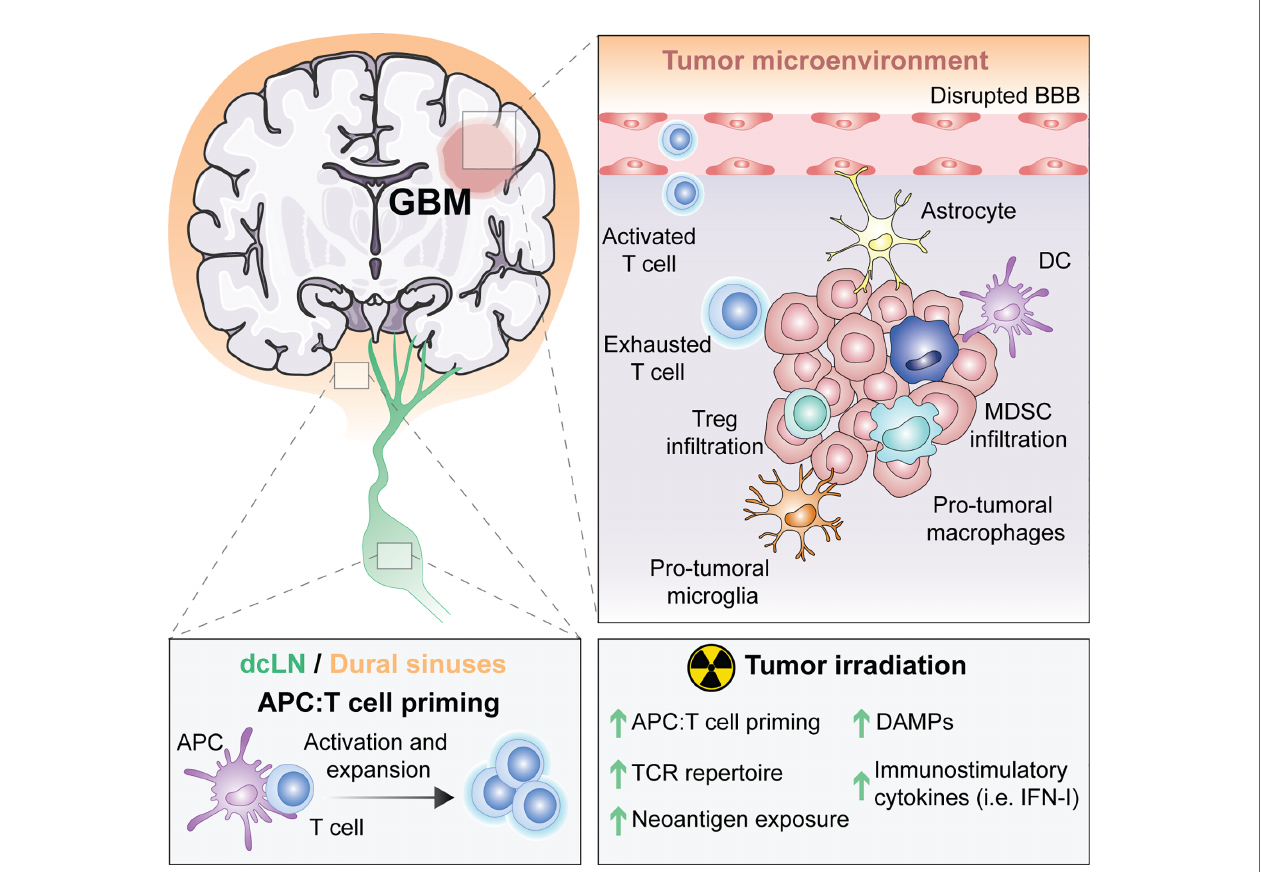
FIGURE 1 | The unique immune response in GBM and its modulation by RT. For many years, the central nervous system (CNS) was thought to be excluded from immune surveillance. However, it is now known that the CNS is not isolated from activated T cells and that CNS antigens can be presented locally or peripherally in the draining cervical lymph nodes or the dural sinuses. Diverse types of antigen presenting cells (APCs) exist within glioblastoma (GBM), including microglia, macrophages, astrocytes and classic APCs such as dendritic cells (DCs). APCs that have captured tumor antigens can present to naïve T cells, leading to their activation and expansion. Activated T cells migrate into the brain through a disrupted blood brain barrier (BBB), but once in the tumor microenvironment (TME) they differentiate into exhausted T cells. Within the TME, there are immunosuppressive regulatory T cells (Tregs), myeloid derived suppressor cells (MDSC), reactive astrocytes and pro-tumoral macrophages and microglia. Radiotherapy (RT), the standard of care for GBM, induces the exposure of tumor neoantigens and increases the T cell receptor (TCR) repertoire. Moreover, tumor irradiation promotes the release of danger associated molecular patterns (DAMPs) and type I interferon (IFN-I), which stimulate APCs cross-priming of T cells. All of these suggest that RT can be used to overcome GBM immunosuppression to optimally prime anti-tumor